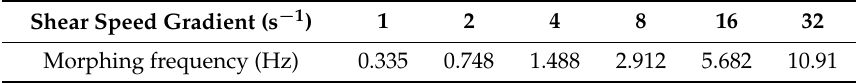
Table 1. The variation of the morphing frequency with the shear wave speed